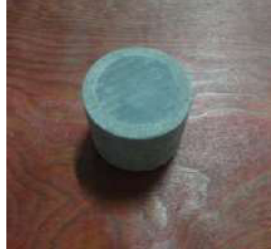
Figure 18. Modeled aggregate MRCA [45]. Reproduced with permission from [45], Elsevier, 2018.